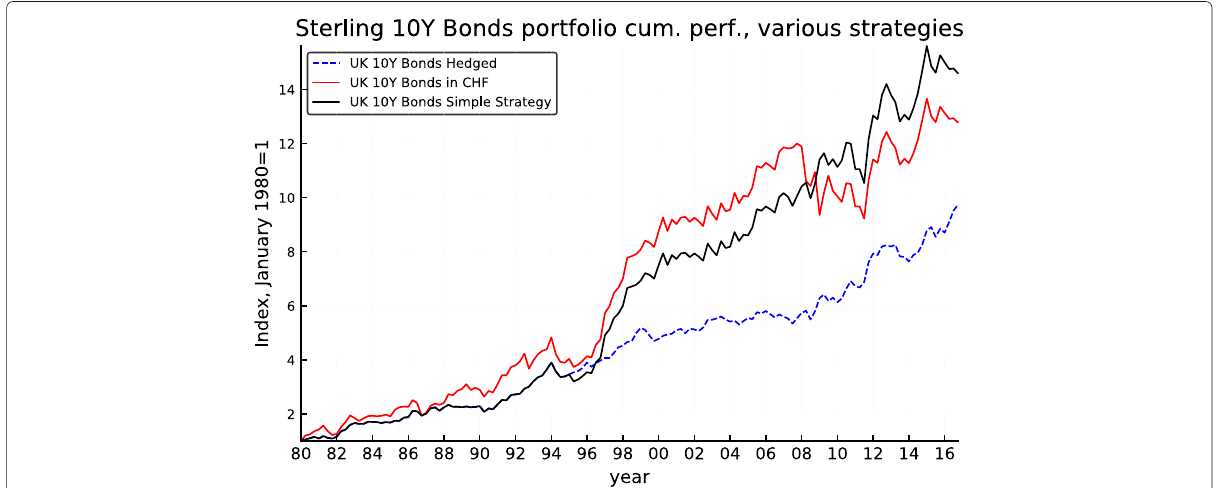
Fig. 9 Sterling 10-year bond cumulative performance: unhedged, hedged, and simple strategy